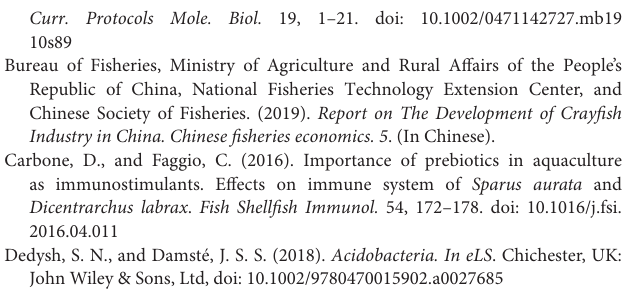
Supplementary Table 1 | OUT reads number raw data of all samples. Supplementary Table 2 | Alpha-diversity indices of all samples. Supplementary Table 3 | Attributes of the co-correlation network. Supplementary Table 4 | The environmental physico-chemical properties in MC and RC breeding